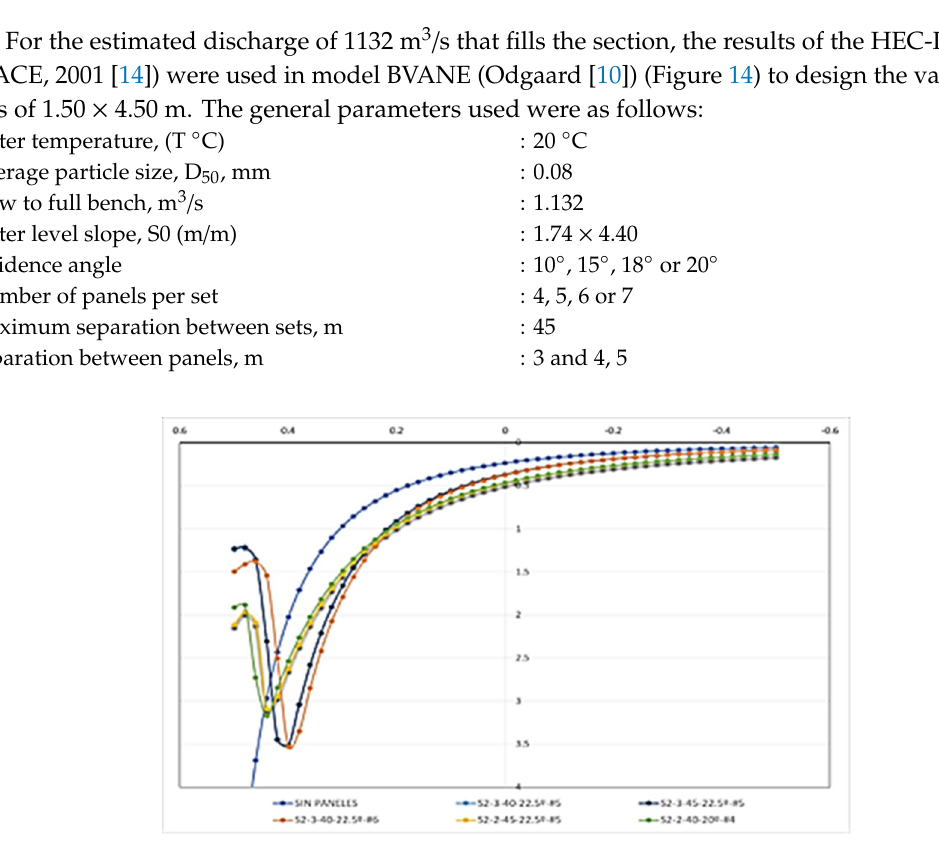
Figure 14. Rio Metica, Puerto López: optimal selection for the vane system.